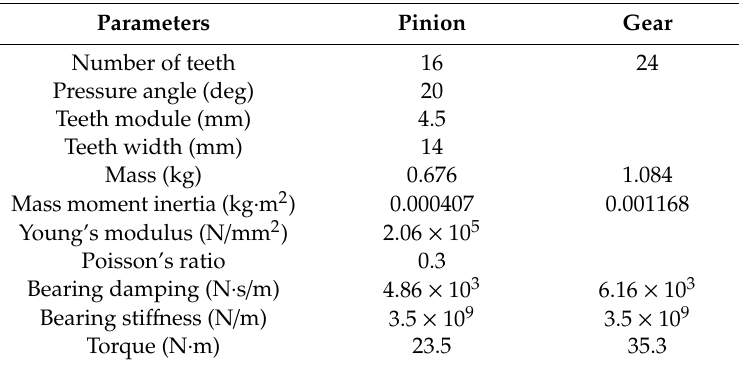
Table 1. Parameters for the dynamic simulation.